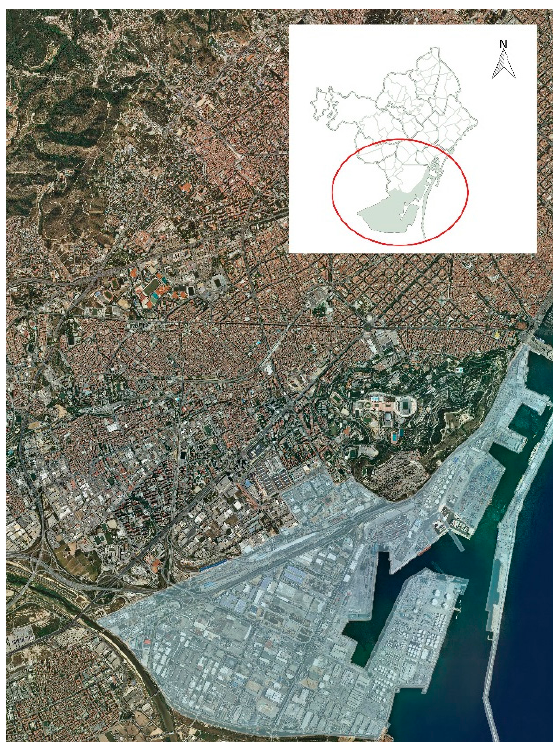
Figure 7. Location of the La Marina del Prat Vermell neighborhood.